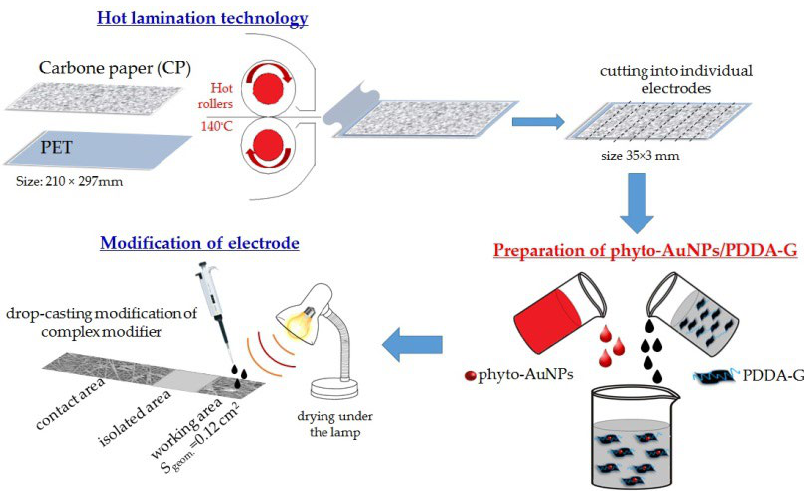
Figure 2. Fabrication of modified carbon paper electrodes.